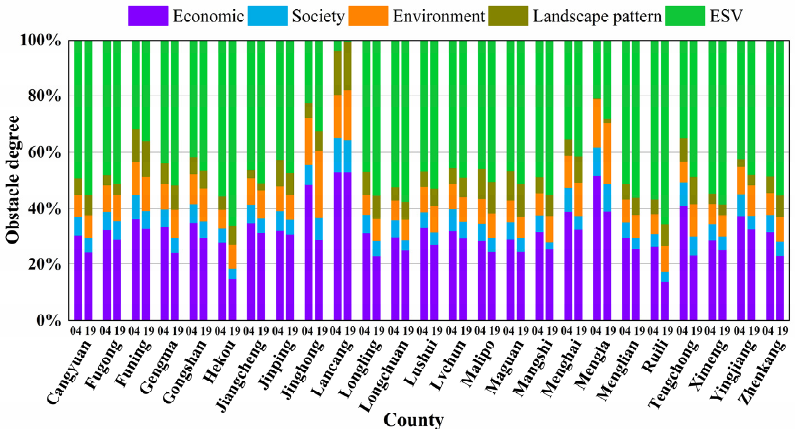
Figure 7. The obstacle degree of each element of ecological security in 25 border counties in Yunnan Province, China for economic, social, environmental, landscape pattern, ecosystem service value (ESV). Note: 04 and 19 indicate the years of 2004 and 2019,